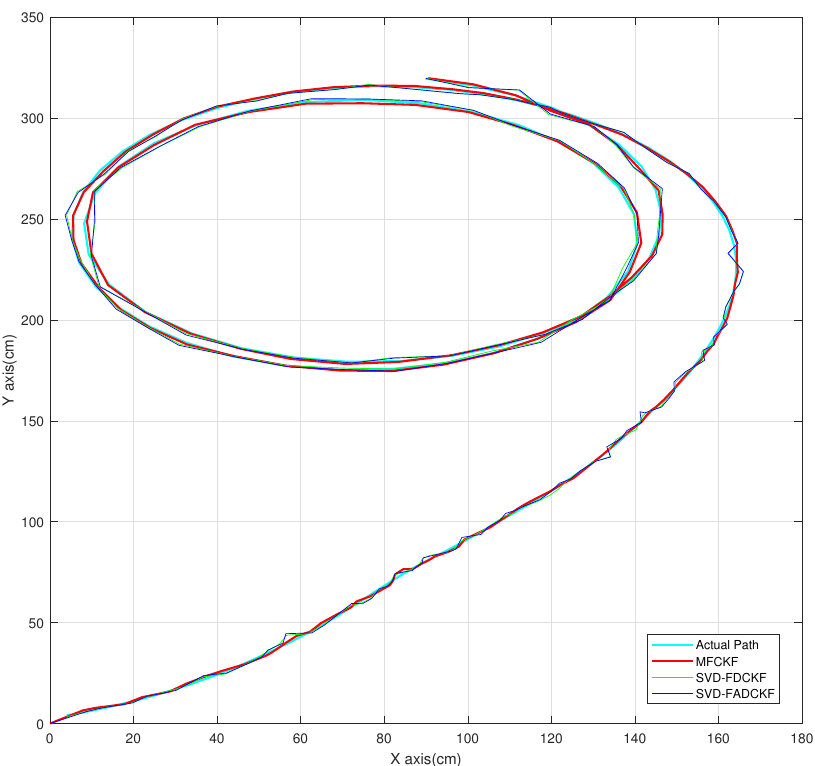
Figure 4. Simulation paths of different algorithms.